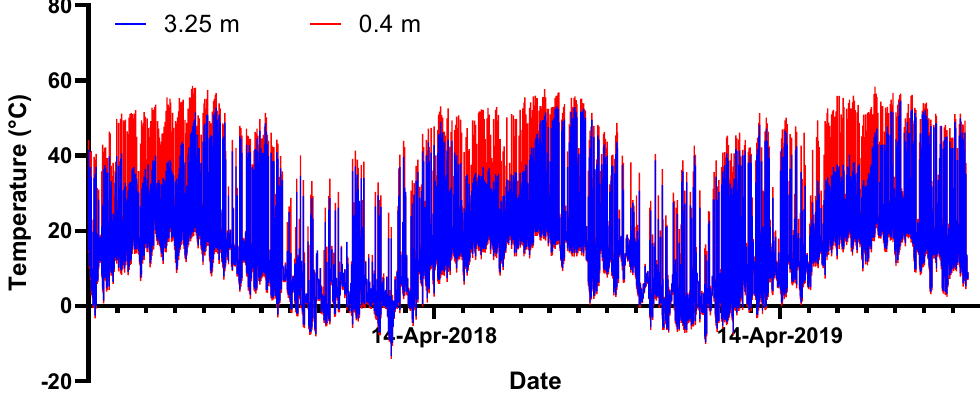
Figure 4. Influence of distance from the ground on the temperature dynamics on the façade in the period between 13th of July 2016 and 15th of July 2019. Each curve represents 22,300 measurements.